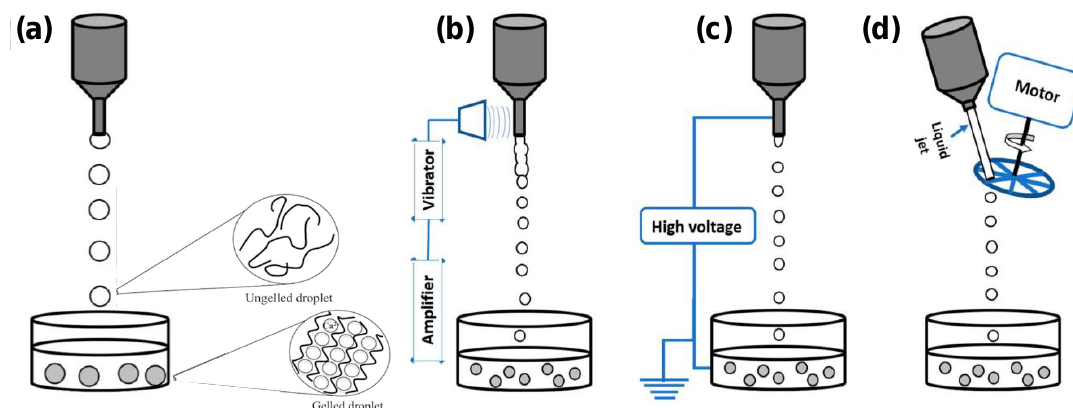
Figure 2. Illustration of dripping devices: ( a ) conventional dripping method influenced by gravity, surface tension and viscosity; breaking up of liquid jets into droplets stimulated by ( b ) vibrating nozzle method, ( c ) electrostatic forces and ( d ) a mechanical cutting device. Reprinted (with some modifications) from [4] . Copyright (2018) Ganesan, Budtova, Ratke, Gurikov, Baudron, Preibisch, Niemeyer, Smirnova, Milow.